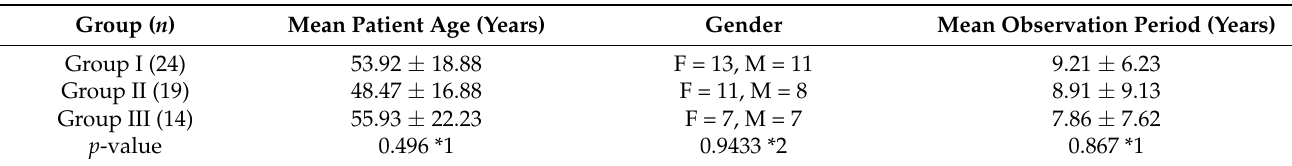
Table 2. Patient age, gender, and observation periods in each Group of the clinical study (I: biopsy proven, II: bilateral hilar lymphadenopathy (BHL) positive, III: BHL negative).